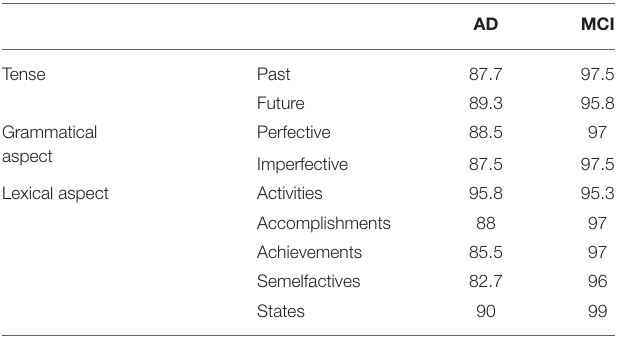
Table 6 . As with the sentence completion task, a binary logistic